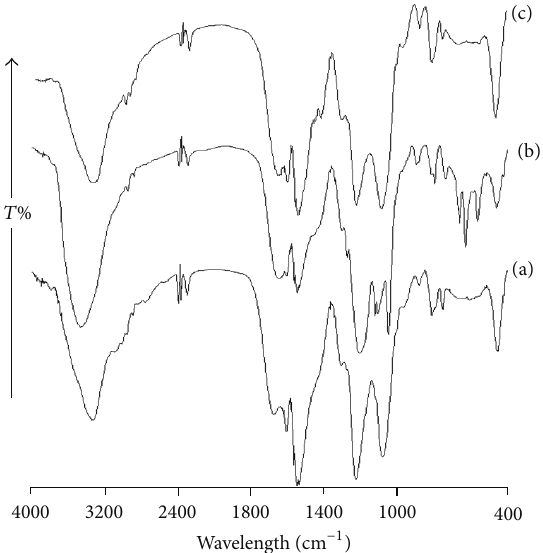
Figure 3: FTIR spectra of MCM-PS-TDI-C4 (a), MCM-PS-TDI- C4S (b) and MCM-PS-TDI-PC4